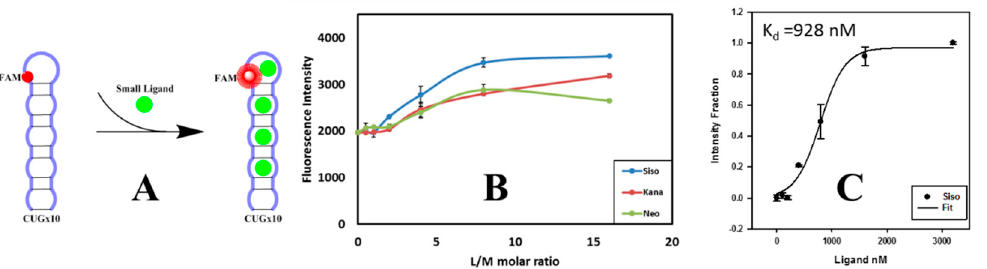
Figure 2. Aminoglycoside comparison experiments: ( A ) ligand binding scheme; ( B ) binding com- parison of three aminoglycosides targeting FAM modified r(CUG) 10 with ligand to RNA molar ra- tios—L/M at 0, 0.5, 1, 2, 4, 8, and 16; and ( C ) sigmoidal fitting of sisomicin binding data and calcu- lated K d value.